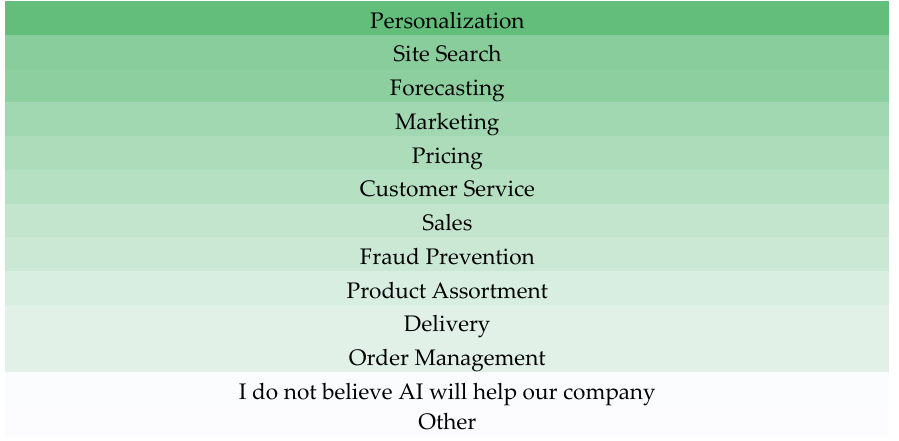
Figure 1. Future areas in which AI will help e-commerce businesses, according to decision makers in North America and Europe in 2021. Data source: [28].